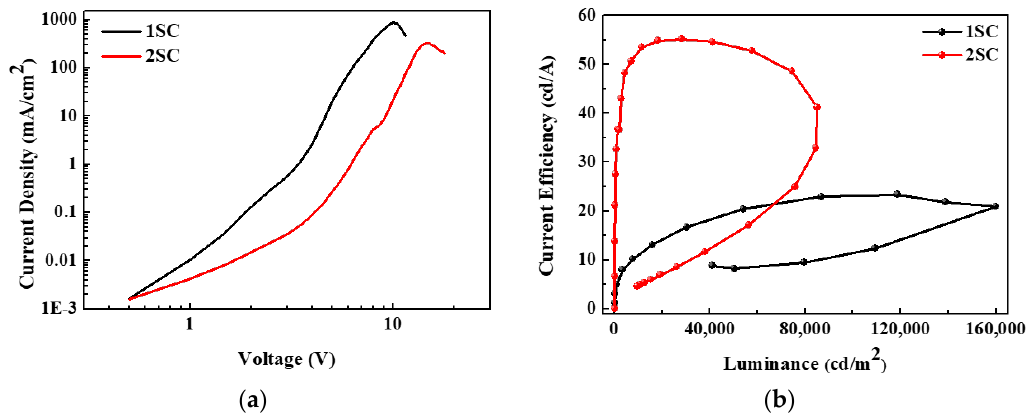
Figure 5. ( a ) Current density–voltage and ( b ) current efficiency–luminance characteristics of QLEDs with 1SC and 2SC of the ZnO layer.